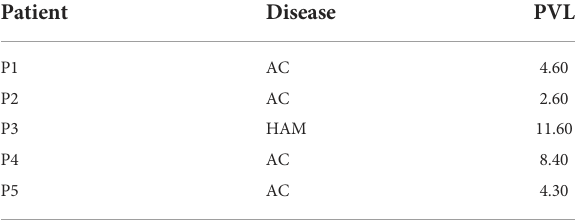
TABLE 2 Patient PBMC samples used for ex vivo